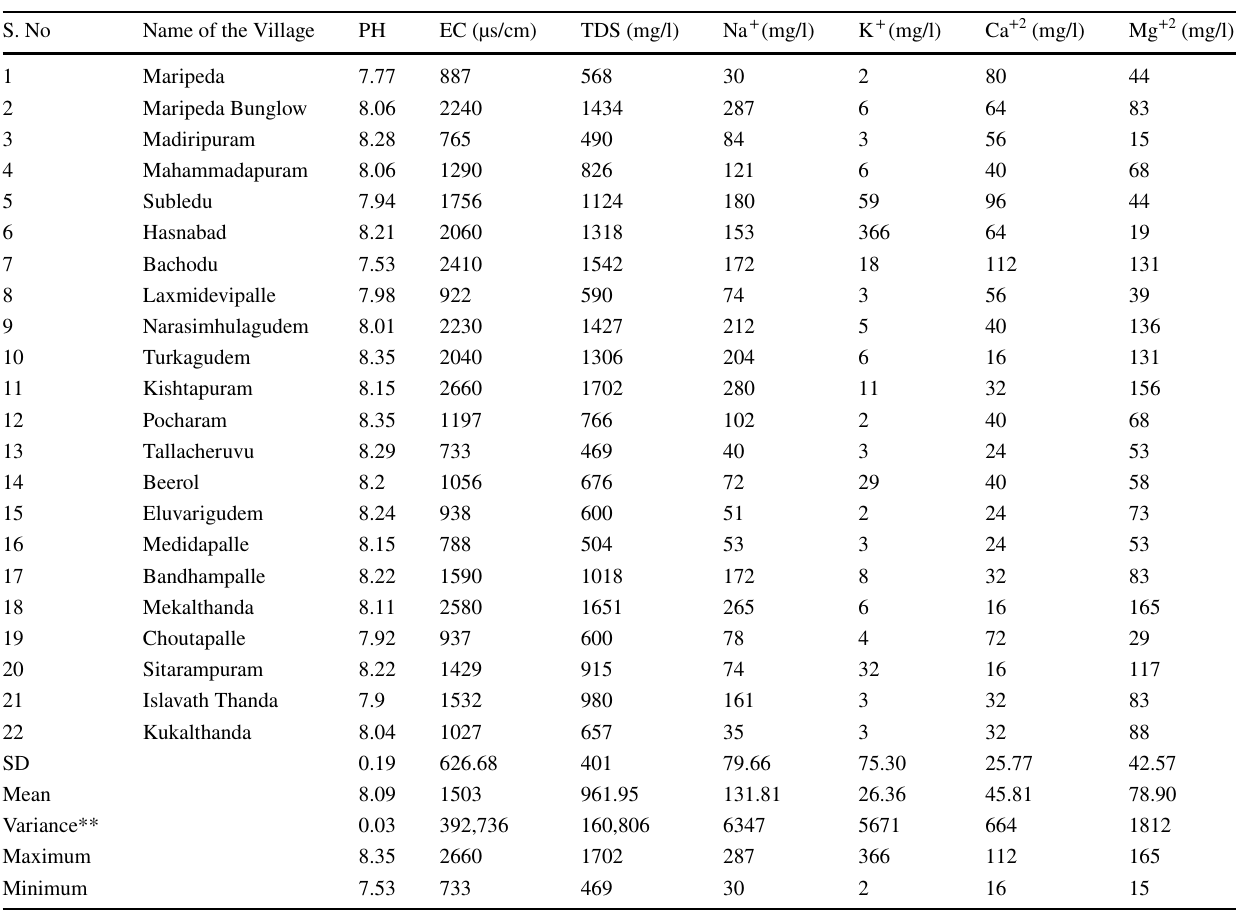
**Variance is expressed in mg/l 2